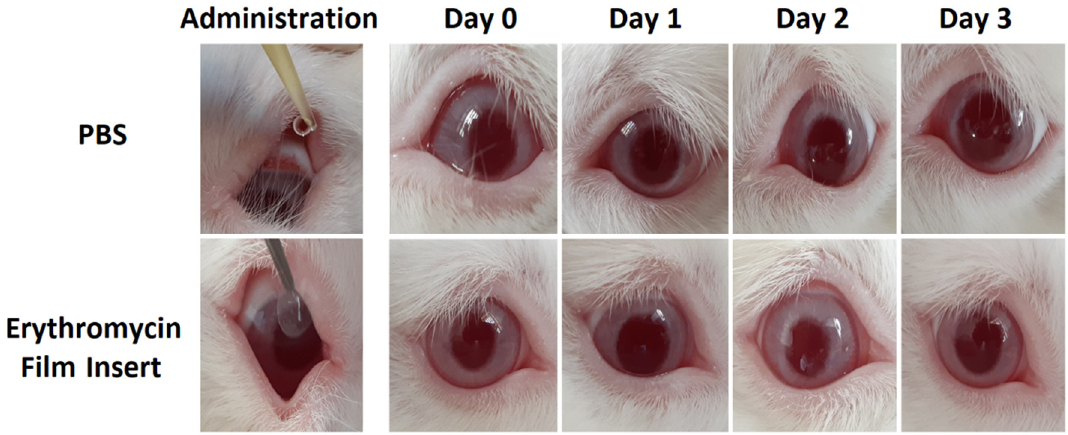
Figure 6. Images of rabbits’ eyes treated with phosphate buffer solution (PBS) and ALG ocular insert during 3 days of examination by Draize test.